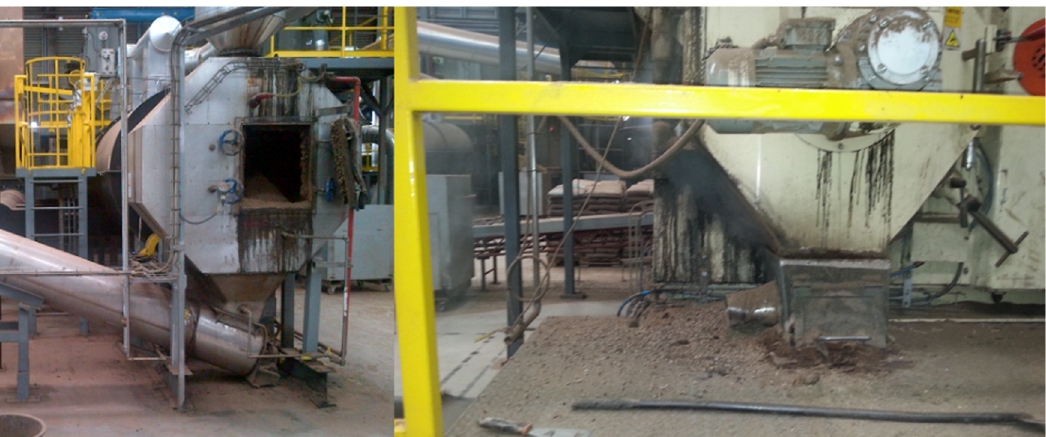
Figure 13. Condensation of gases forming runoff along the surface of the equipment. Left: runoffs from the manhole door of the reactor discharge chamber. Right: runoffs on the door of the pelletizer itself, that is, in the final section of the production line.